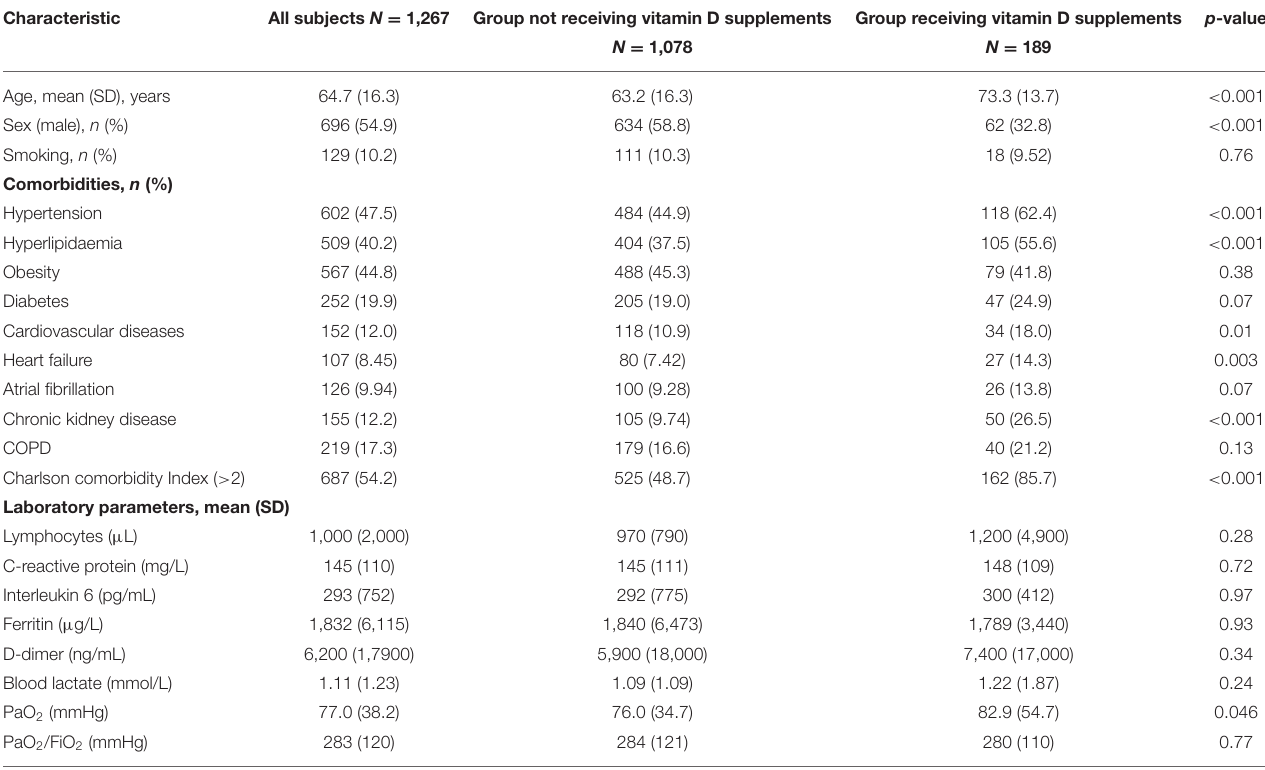
TABLE 1 | Baseline characteristics of all subjects and according to vitamin D supplements.